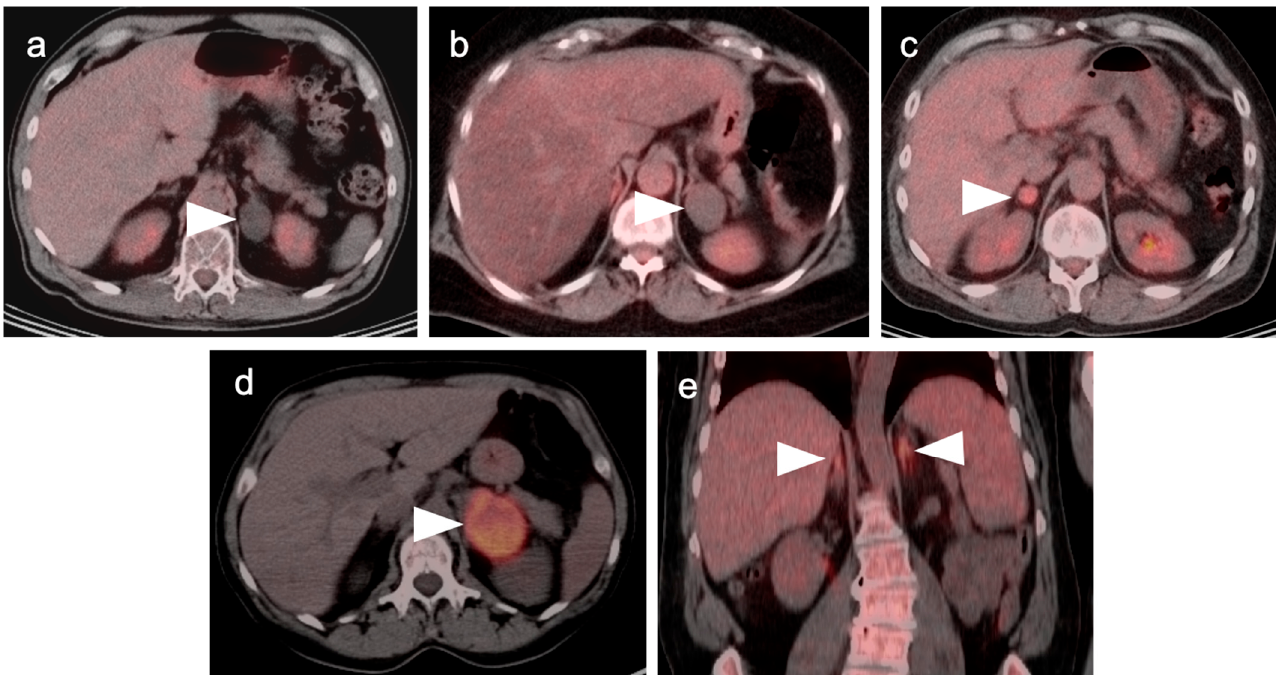
Figure 25. Variable appearance of adrenal lesions (white arrowheads) on FDG PET-CT: ( a ) Axial fused FDG PET-CT. A left adrenal nodule (white arrowhead) is low in attenuation (<10 HU) and is without appreciable metabolic activity, typical findings of lipid-rich adenoma; ( b ) Axial fused FDG PET-CT. Attenuation is slightly higher (HU 15) and metabolic activity is lower in this adrenal nodule, compared to the metabolic activity of the liver, supporting that this is likely a benign nodule but warrants follow-up for confirmation of stability. Note there is also geographic hepatic steatosis on CT; ( c ) Axial fused FDG PET-CT. A small adrenal nodule demonstrates metabolic activity 1.8 times that in the liver. This is suspicious for malignancy and further workup is warranted; ( d ) Axial fused FDG PET-CT. A large intensely hypermetabolic adrenal mass is a metastasis vs. adrenal cortical cancer (in this case it was a metastasis from a primary was non-small cell lung cancer); ( e ) Coronal fused FDG PET-CT image. Symmetrical hypermetabolism in both adrenal glands without nodularity may represent stressed-induced adrenal activation or adrenal